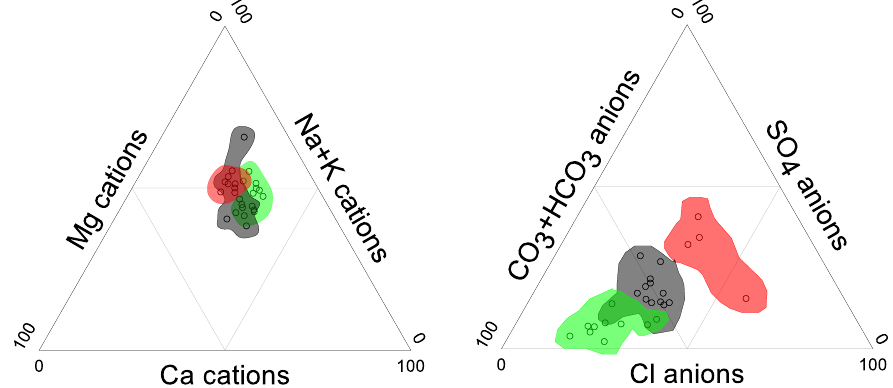
Figure 2. Trilinear diagrams for cations and anions indicating the HCA statistical groups: Group 1, in green, stands for samples located in the triangle of Tecate-La Rumorosa-El Hongo. Group 2, in grey, represent samples in Tecate, La Rumorosa and El Hongo. Group 3, in red, considers samples south and southeast of Tecate.